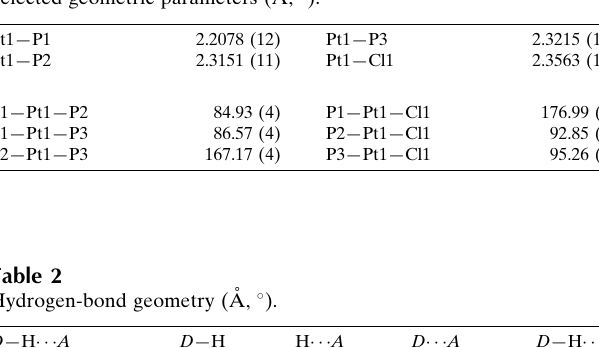
Selected geometric parameters (A˚ , (cid:3) ).